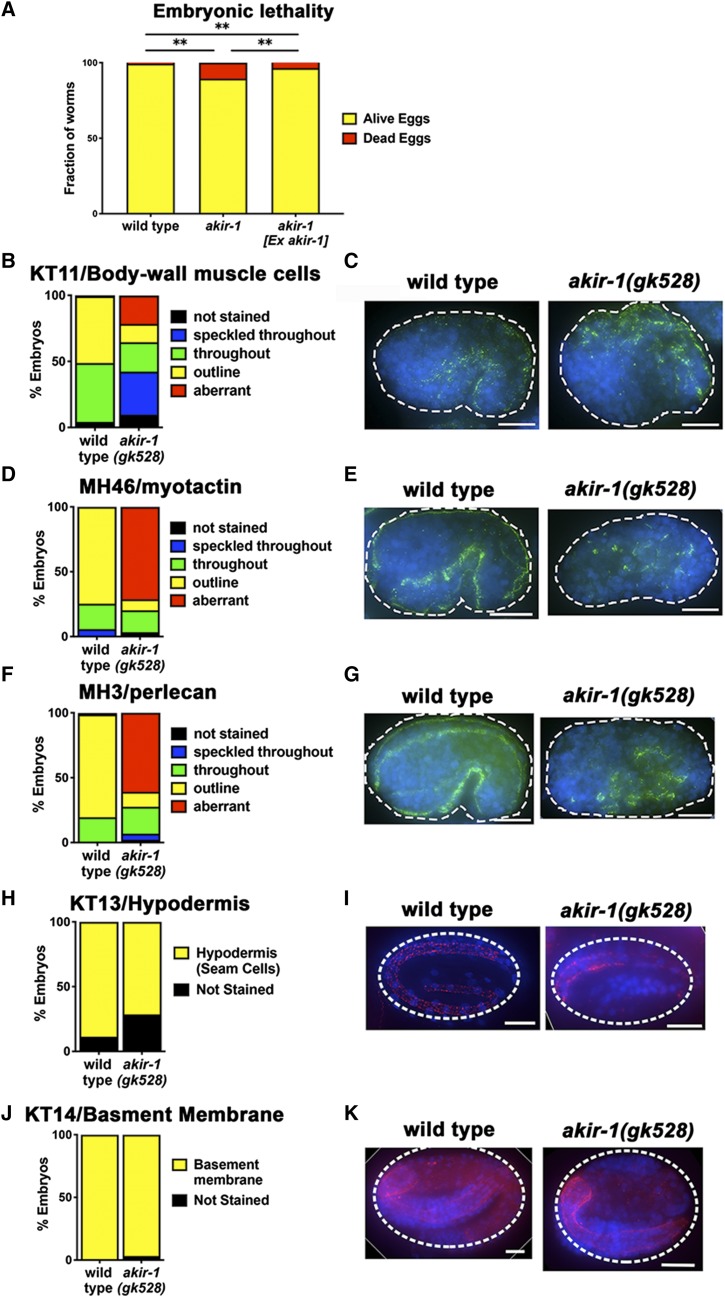
AKIR-1 is required for proper embryonic development. A) Embryonic lethality (eggs laid not developed to adult worms). Wild type n = 2298, akir-1(gk528) n = 598. akir-1(gk528) with wild type akir-1 in an extra-chromosomal array had an embryonic lethality of 3.6% (n = 2800, P < 0.0001, Fisher’s Exact test). B-G) Immunolocalization of antibodies for embryonic tissues: B-G embryos at the bean stage, H embryos at the 1 to 3 fold stage, and J embryos and the 2 to 3 fold stage. B) Percent of embryos with the indicated staining pattern for KT11. Wild type n = 168, akir-1(gk528) n = 144. C) Antibody staining of KT11; representative images of the most frequent staining pattern observed for each genotype. D) Percent of embryos with the indicated staining pattern for MH46. Wild type n = 138, akir-1(gk528) n = 59. E) Antibody staining of MH46; representative images of the most frequent staining pattern observed for each genotype. F) Percent of embryos with the indicated staining pattern for MH3. Wild type n = 184, akir-1(gk528) n = 87. G) Antibody staining of MH3; representative images of the most frequent staining pattern observed for each genotype. H) Percent of embryos with the indicated staining pattern for KT13. Wild type n = 44, akir-1(gk528) n = 7. I) Antibody staining of KT13; representative images of the most frequent staining pattern observed for each genotype. H) Percent of embryos with the indicated staining pattern for KT14. Wild type n = 51, akir-1(gk528) n = 30. I) Antibody staining of KT14; representative images of the most frequent staining pattern observed for each genotype. Scale bars 10μm. Statistics: A ** 0.001 ≤ P < 0.01., B, D and F outlined staining vs. all other Fisher’s exact test, all significant P < 0.001, H and J stained vs. not Fisher’s exact test, both non-significant P = 0.2422, P = 0.3704 respectively.